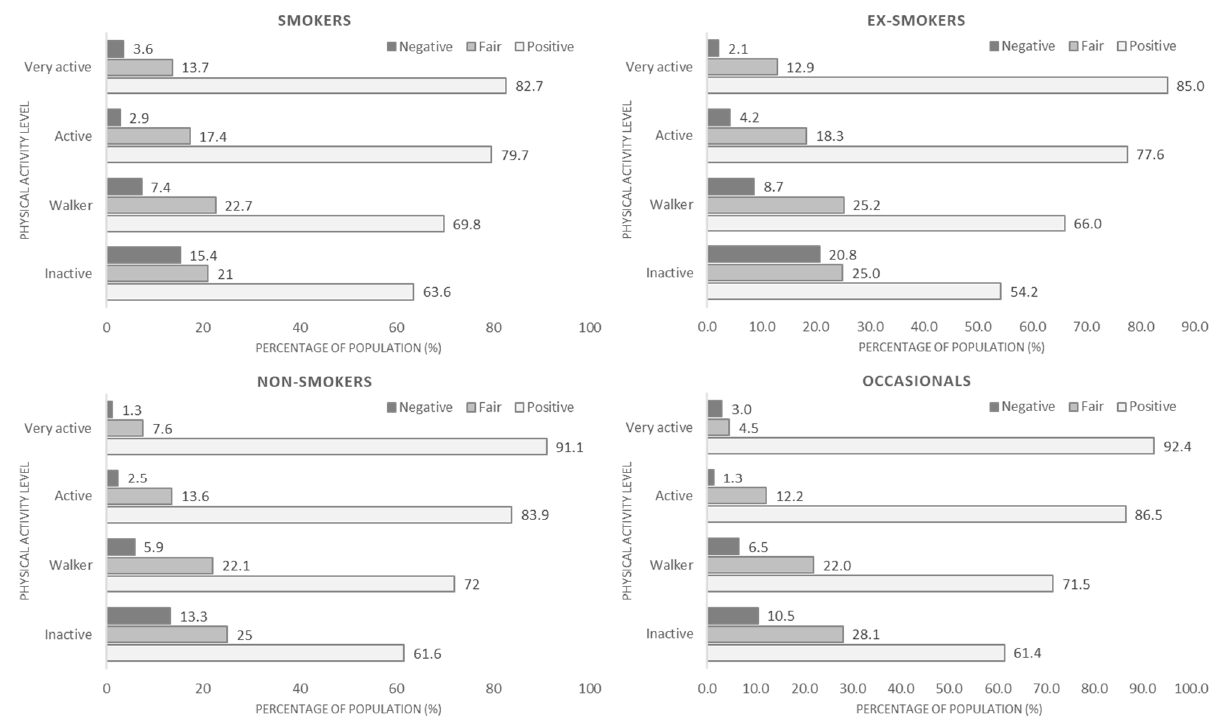
Figure A3. Self-perceived health of the Spanish population, according to their smoking status.